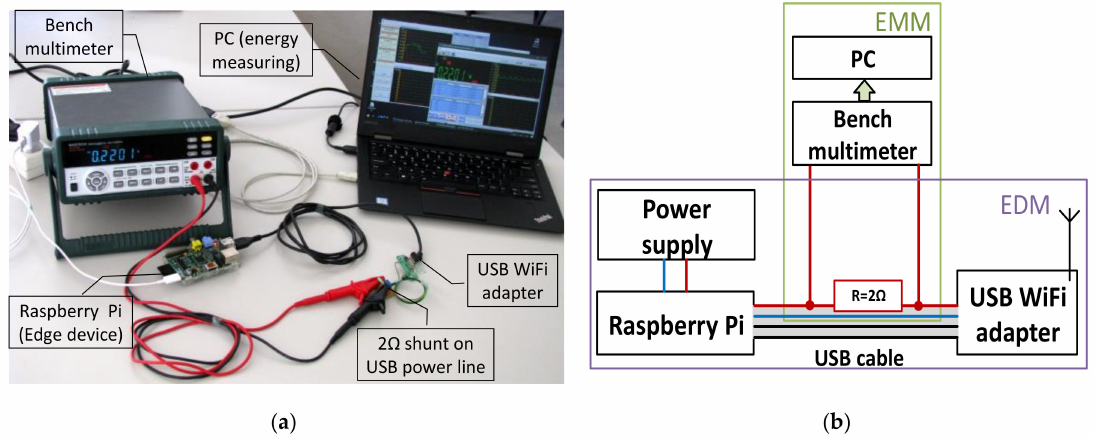
Figure 4. Energy consumption measurement setup: ( a ) Overall picture of the setup, ( b ) principal diagram of the setup, here EDM—Edge device module, EMM—energy measuring module